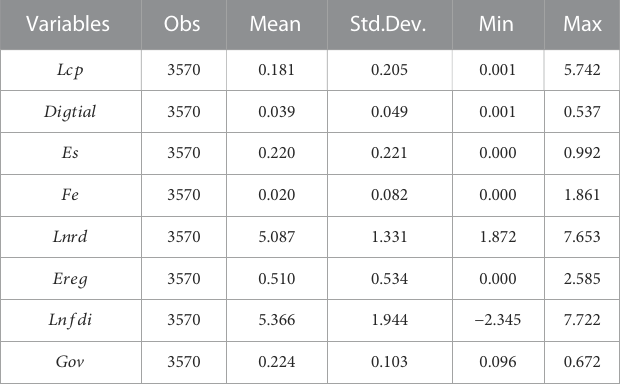
TABLE 4 Descriptive statistics of main